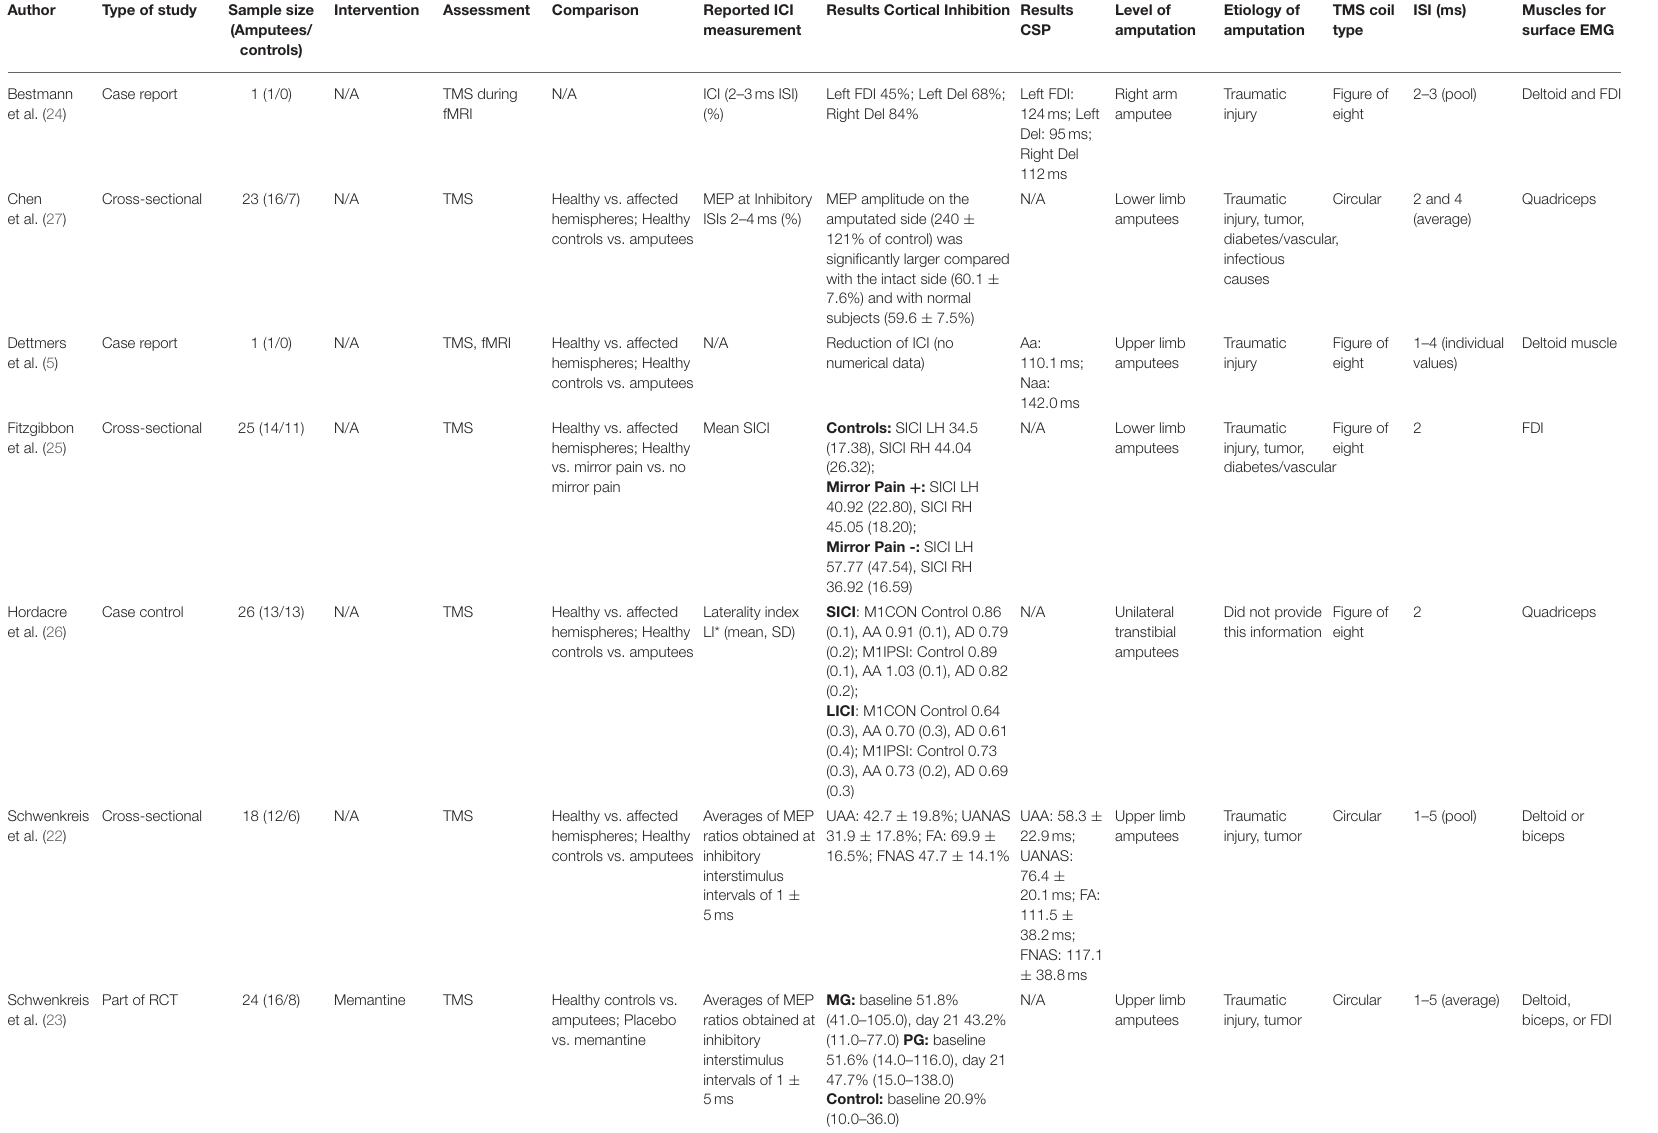
Left FDI, Left first dorsal interosseous; Left Del, Left Deltoid; Right Del, Right Deltoid; Aa, affected arm; Na, non affected arm; LH, left hemisphere; RH, right hemisphere; AA, amputee admission; AD, amputee discharge; UAA, upper arm amputation affected side; UANAS, upper arm amputation non affected side; FA, forearm amputation affected side; FNAS, forearm amputation non affected side; MG, memantine group; PG, placebo group; w, week. * LI: (MEP amplitudeM1CON – MEP amplitudeM1IPSI). (MEP amplitude M1CON + MEP amplitude M1IPSI). M1, motor cortex; CON, contralateral; IPSI,